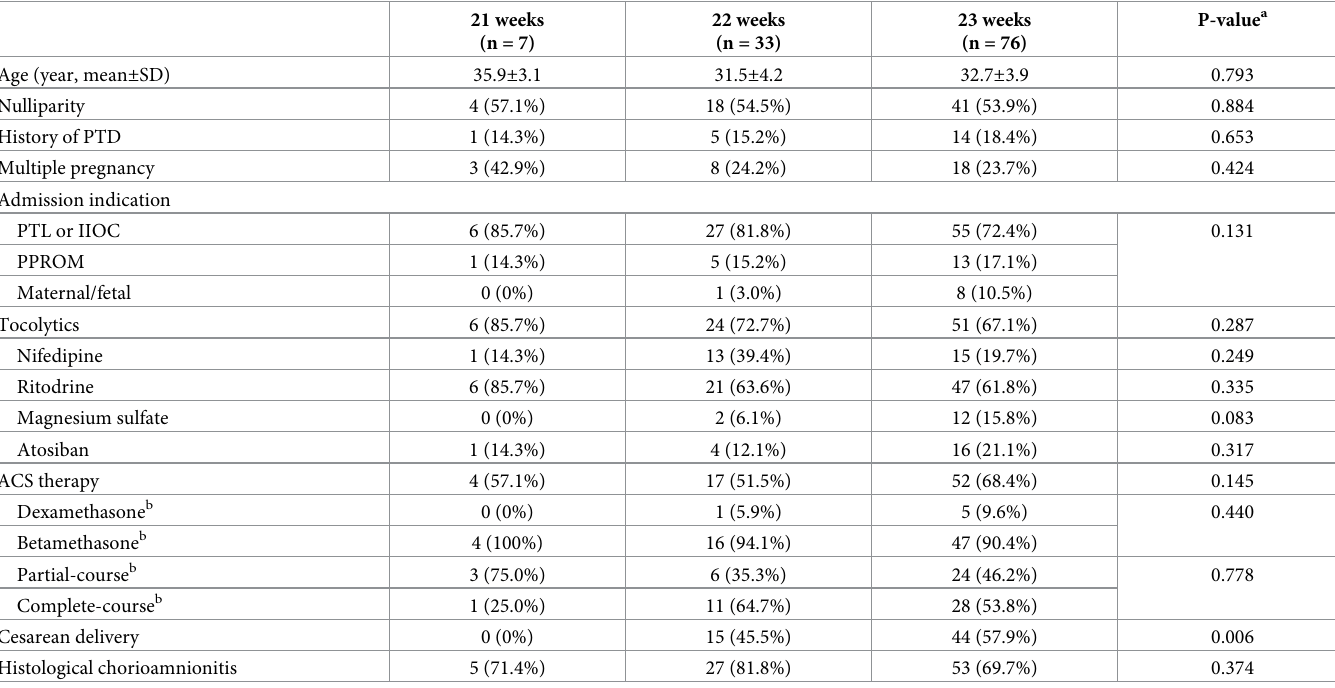
Table 1. Maternal characteristics and pregnancy outcomes according to gestational age at